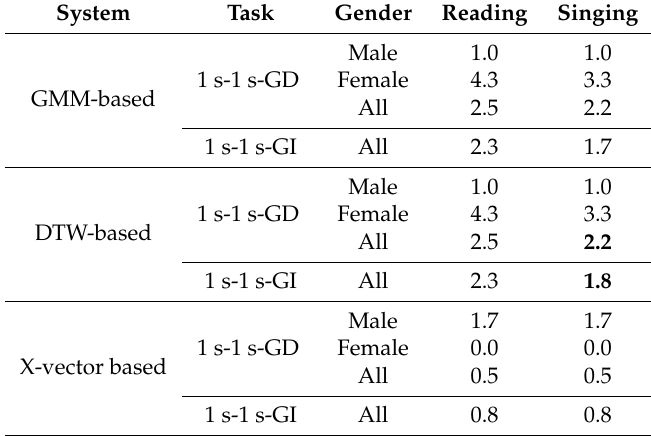
Table 3. EER% comparison on 1 s-1 s text-dependent ASV tasks, using different systems. System